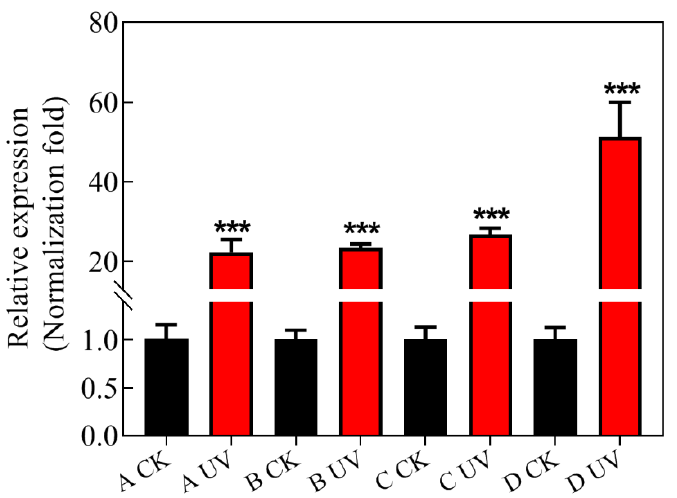
Figure 6. Quantitative Real-Time PCR was carried out with quantification of RAD23 in each isolate, relative to the Actin A housekeeping gene, using the 2 − ∆∆ CT method. The CK group consisted of control isolates without UV irradiation, and, in the UV group, isolates were exposed to UV irradiation for 20 min per day for eight days. The Actin A housekeeping gene was selected as the internal control. The experiment was repeated three times, using three independent biological replicates, and the average values are reported. The error bars represent the S.D. of the mean. *** p < 0.0001, compared with control groups.